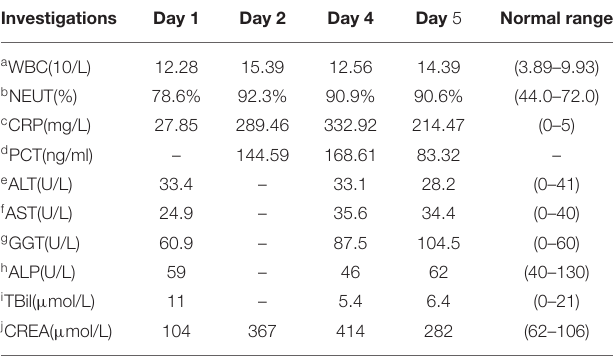
TABLE 1 | Summary of all relevant investigations